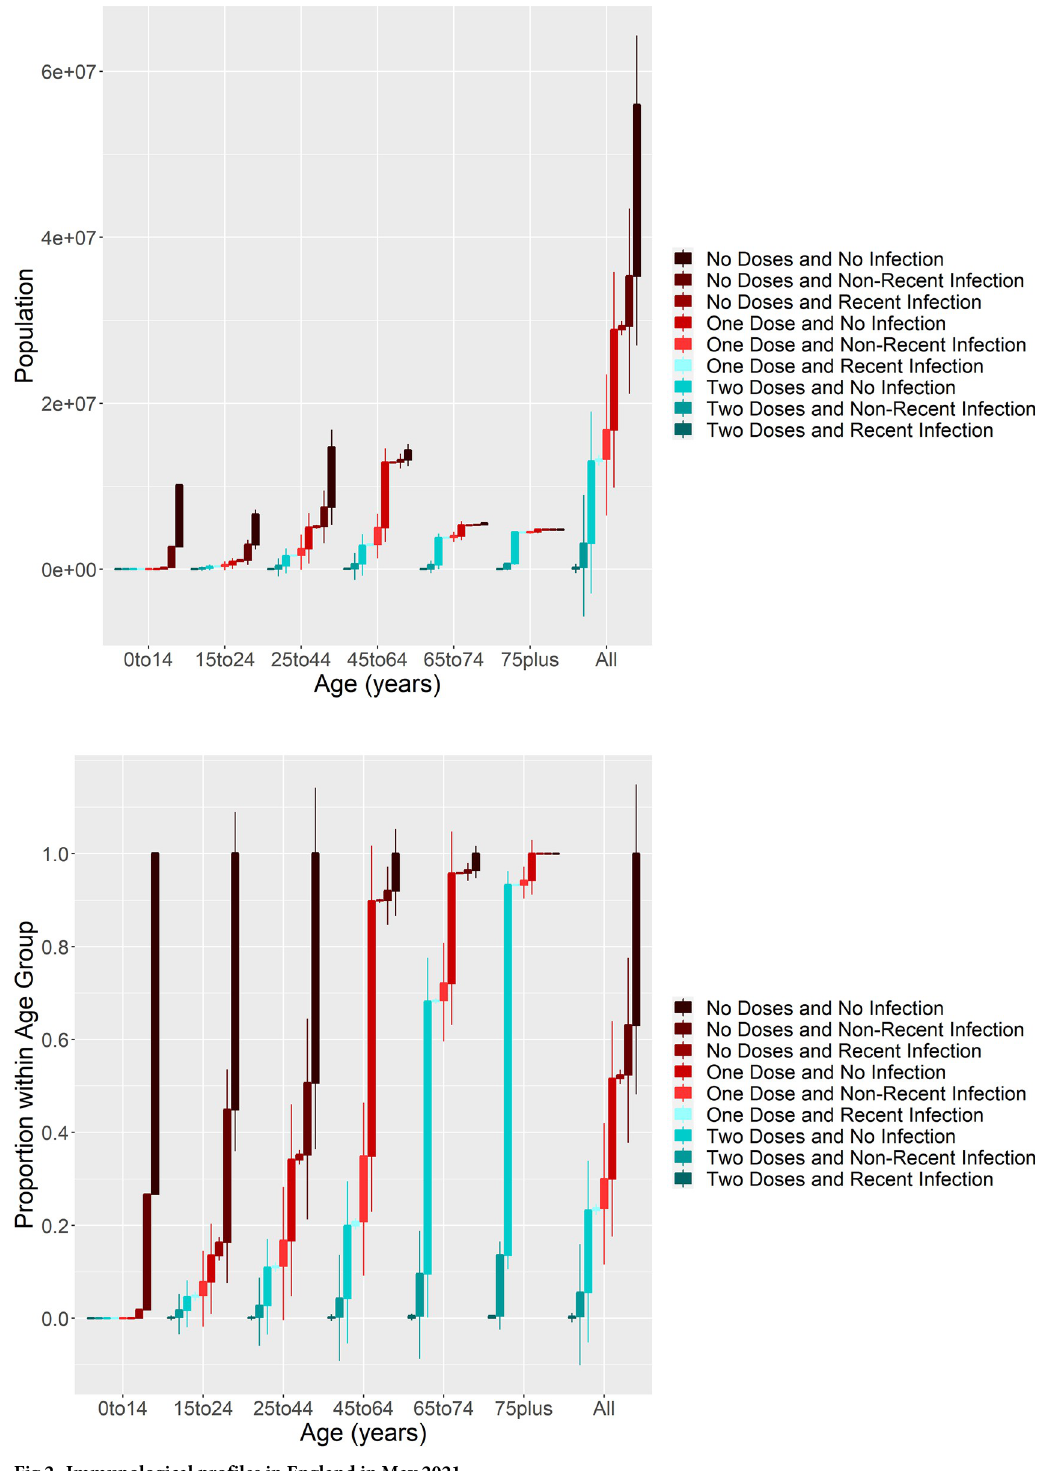
Fig 2. Immunological profiles in England in May